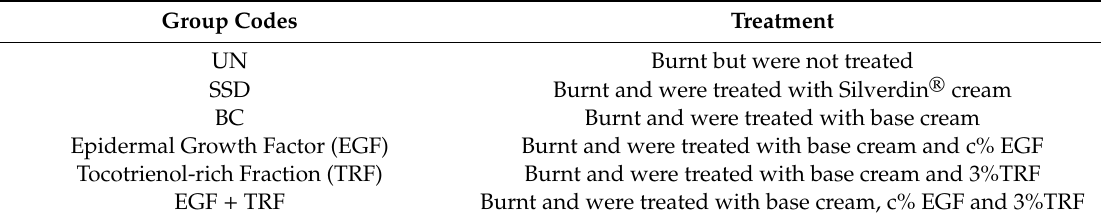
Table 1. The experimental